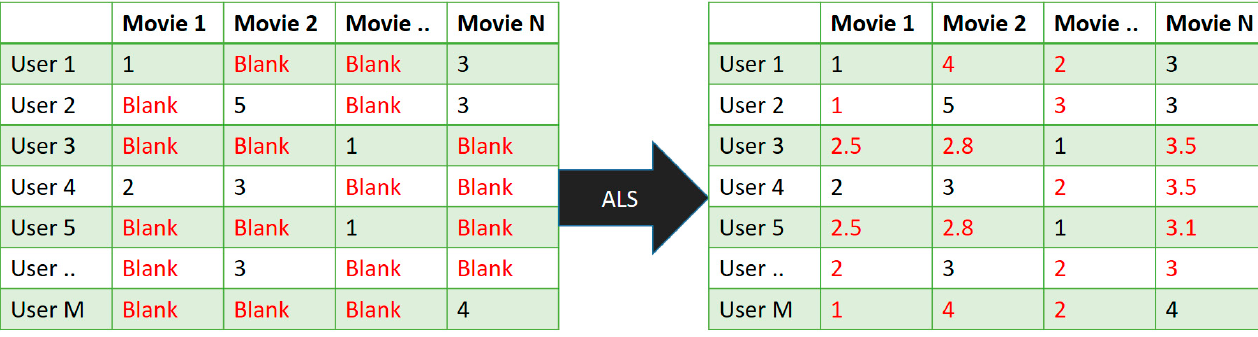
Figure 6. The process of the ALS algorithm.